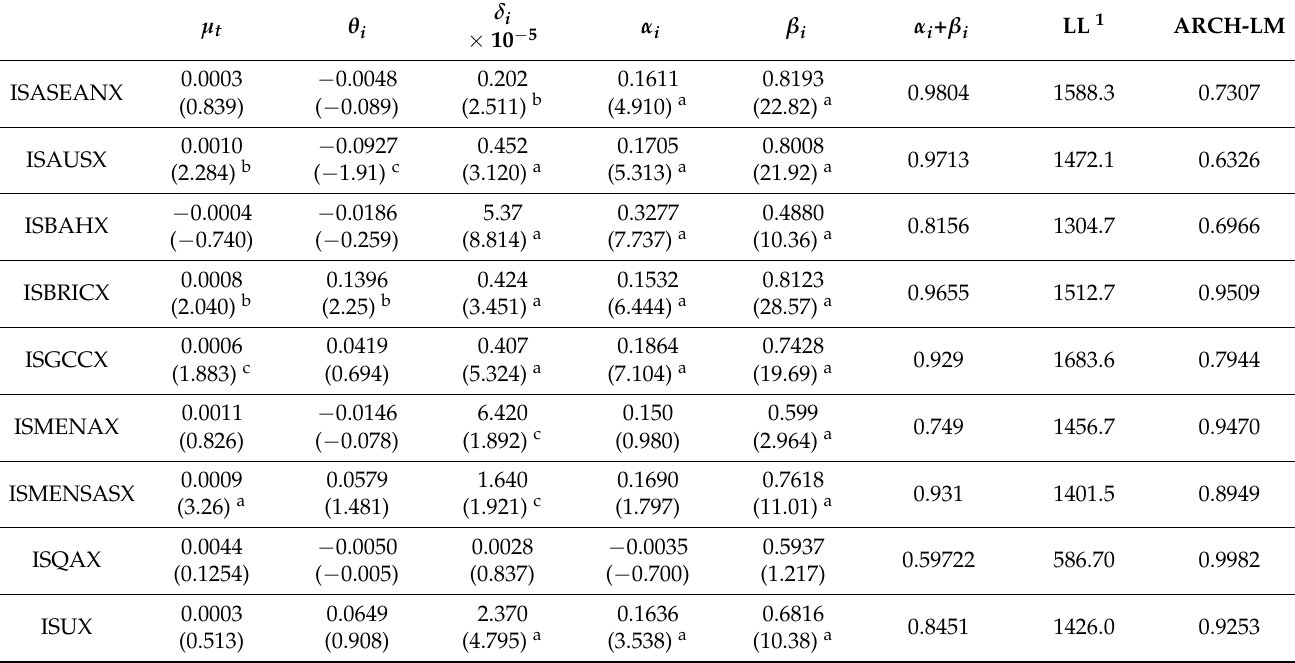
Table 7. GARCH (1, 1) full